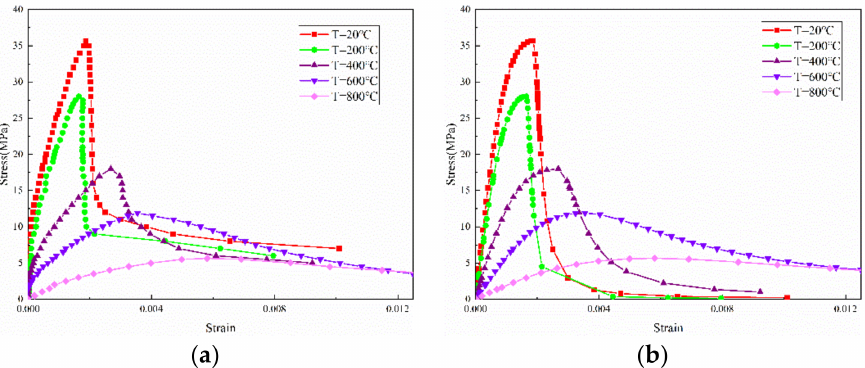
Figure 3. The stress-strain curves of SAC after different temperatures: ( a ) stress-strain curves after different temperatures obtained from the test; ( b ) stress-strain curves after different temperatures obtained by regression fitting.